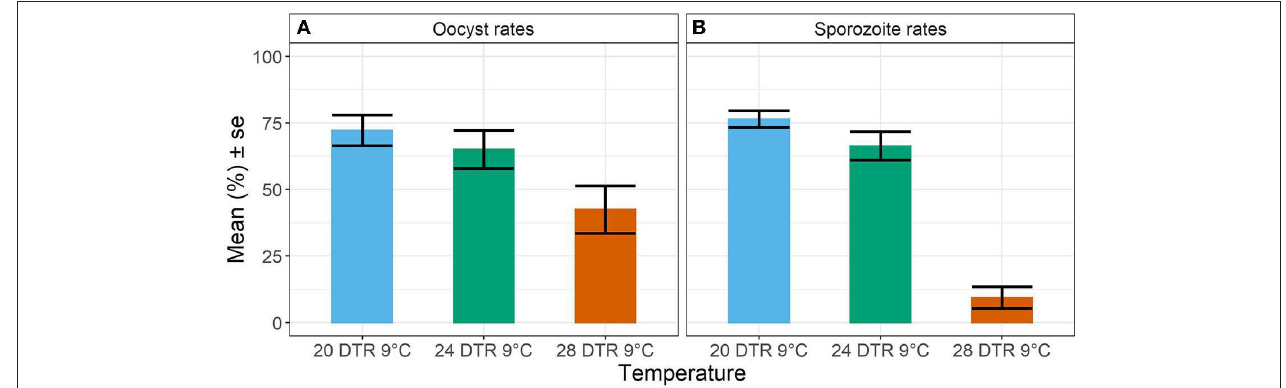
FIGURE 2 | Oocyst rates in midguts (A) and sporozoite rates in salivary glands (B) at the three temperature regimes. Values represents mean ± standard error (se) of prevalence in percent units from three biological replicates.